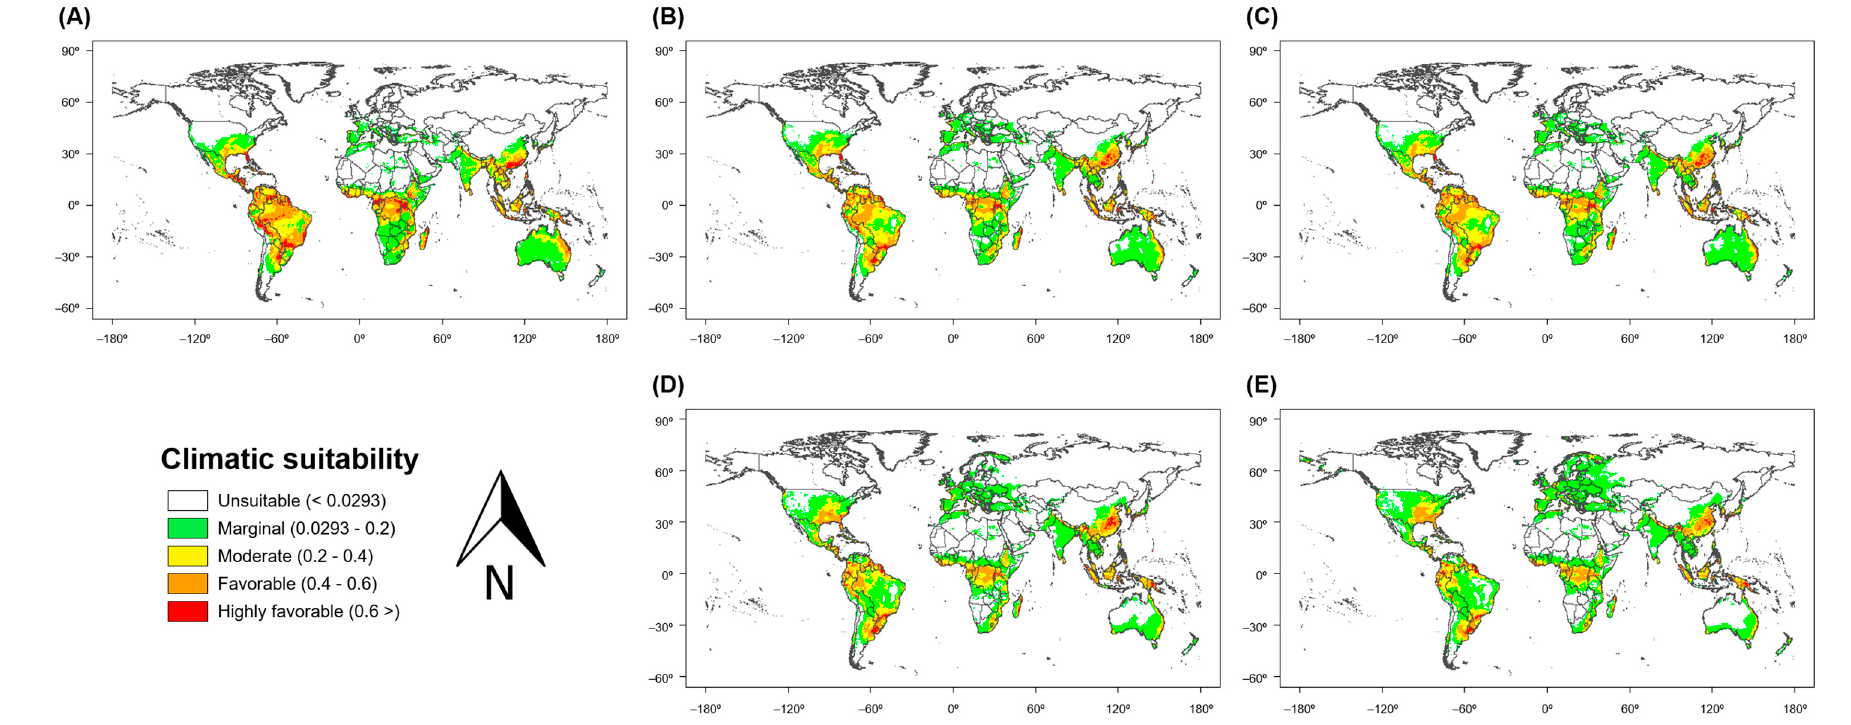
Figure 4. Climatic suitability for S. geminata on a global scale: ( A ) Under current climate conditions, ( B ) in 2050 under scenario A1B and ( C ) scenario A2, and ( D ) in 2100 under scenario A1B and ( E ) scenario A2.